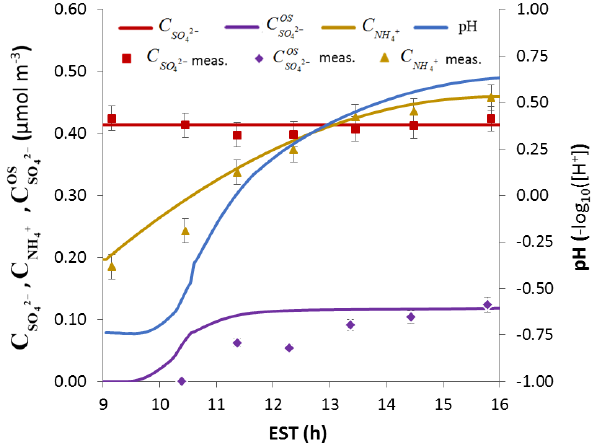
) and Figure 4. Time profiles of the total inorganic sulfate ( C SO 2 − 4 ) concentrations, and RH from experiment SA2, ammonium ( C NH + 4 along with the measured and model predicted concentrations of the ) , and the pre- sulfate associated with organosulfates (OS) ( C OS SO 2 − 4 dicted particle pH. The experimentally measured sulfate and am- Figure 5. Simulated isoprene SOA yields ( Y SOA = (cid:49) OM /(cid:49) Iso) as monium concentrations ( C meas. and C meas.) are shown NH + 4 a function of VOC / NO x (ppbCppb − 1 ) for values 10 to 100. The SO 2 − 4 along with the model values. simulations were performed using the experimental conditions of SA1 (Table 1) without inorganic seed (blue) and in the presence of untitrated sulfuric acid